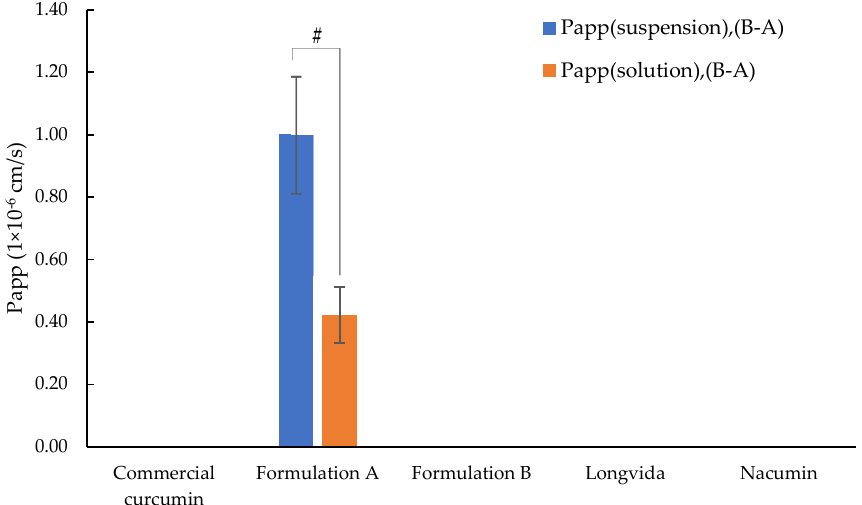
Figure 15. Comparison of Papp (suspension), (B-A) and Papp (solution), (B-A) ( n = 9, mean ± SD) # Denotes statistically significant differences between Papp (suspension), (B-A) and Papp (solution), (B-A) of each formulation ( p ≤ 0.05).